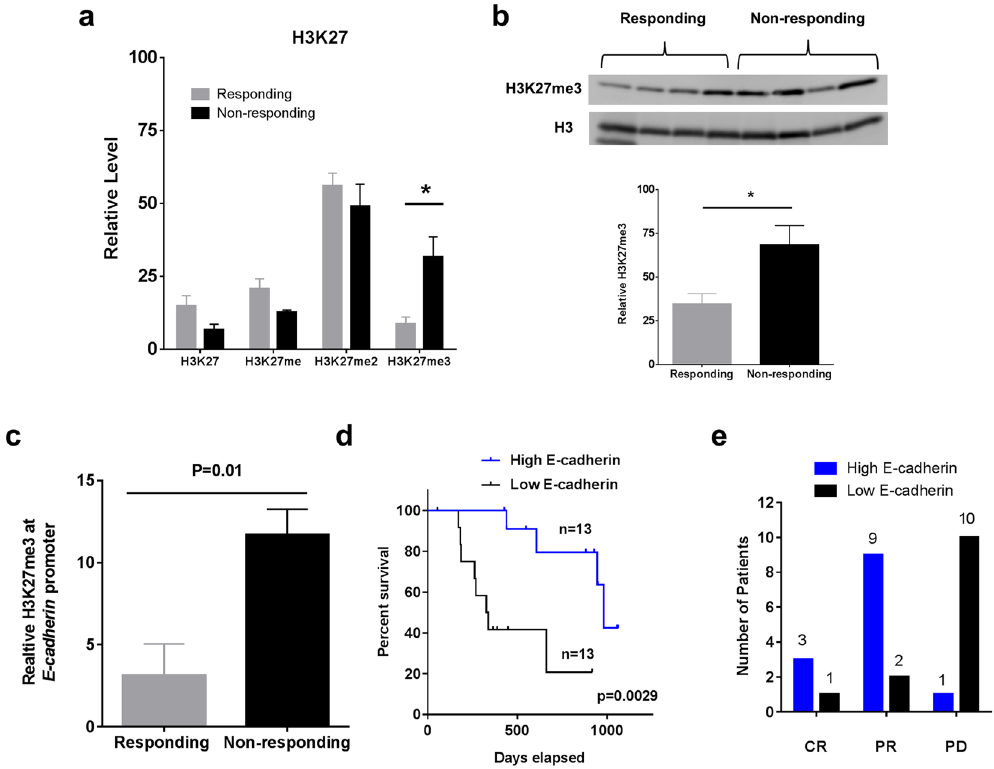
Figure 4. H3K27me3 is upregulated in ICI non-responding tumors. ( a ) Quantitative analysis of histone peptide intensities revealed H3K27me3 was elevated in non-responding tumors relative to responding tumors. Standard error was calculated for the specific peptide in the biological replicate samples as displayed in the chart. N = 4 for responding and non-responding tumors ( * P < 0.019). ( b ) Immunoblot analyses of tumor cell extracts showed elevated H3K27me3 in non-responding tumors. Histone H3 was used as the loading control. Immunoblot quantitation and statistical analysis using ImageJ software and Student’s T test ( * P = 0.019). Full length blots are reported in Supplementary Figure 7. ( c ) ChIP-qPCR performed on FFPE tumor samples with Histone H3 and H3K27me3-specific antibodies followed by qPCR analysis showed significant fold enrichment of H3K27me3 (P = 0.01) at E-cadherin promoter relative to the β -ACTIN promoter, in ICI therapy responding versus non-responding tumors N = 4 per group. ( d ) Overall survival of anti-PD-1-treated patients whose melanoma tumors harbored high (top half) versus low (bottom half) E-cadherin transcripts; p values, log- rank test. N = 13 for both High E-cadherin and Low E-cadherin groups. ( e ) Response designation of anti-PD- 1-treated patients whose melanoma tumors harbored high (top half) versus low (bottom half) E-cadherin transcripts. CR = complete response, PR = partial response, PD = progressive disease, according to irRECIST. N = 13 for both High E-cadherin and Low E-cadherin groups. Error bars denote the